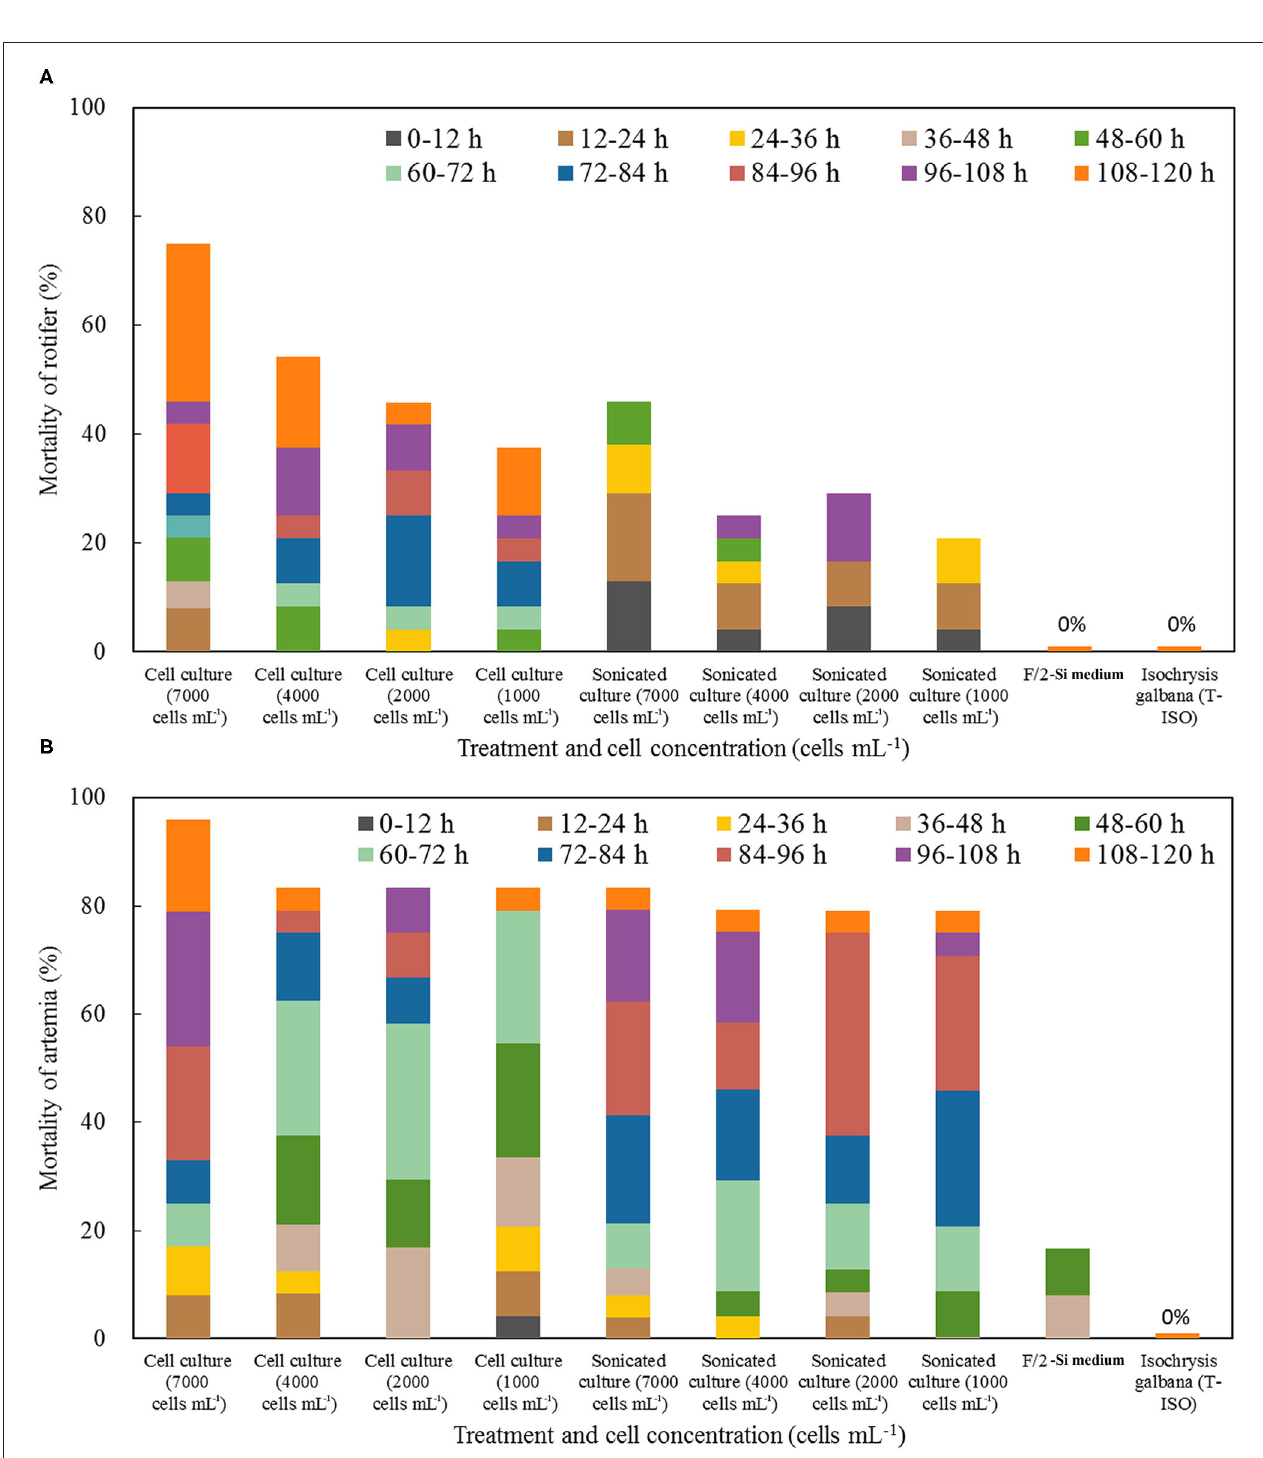
FIGURE 5 | Mortality of rotifer Brachionus plicatilis (A) and brine shrimp Artemia salina (B) treated with a density range of live cells and cell lysates of Alexandrium insuetum within 120h. F/2-Si medium and Isochrysis galbana (T-ISO, nontoxic) were used as negative controls.